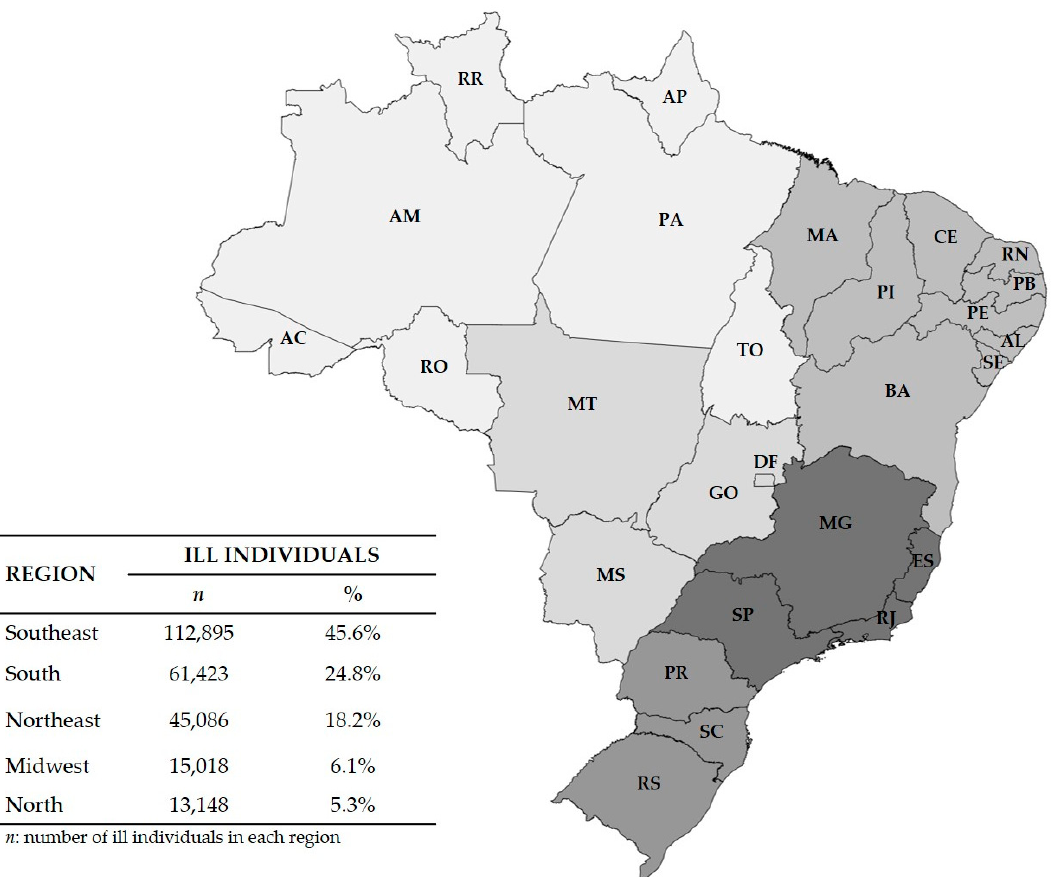
Figure 1. Distribution of ill individuals due to FBD outbreaks by region in Brazil, 2000 to 2018. The map was created by using MapChart. Southeast Region—ES: Esp í rito Santo, MG: Minas Gerais, RJ: Rio